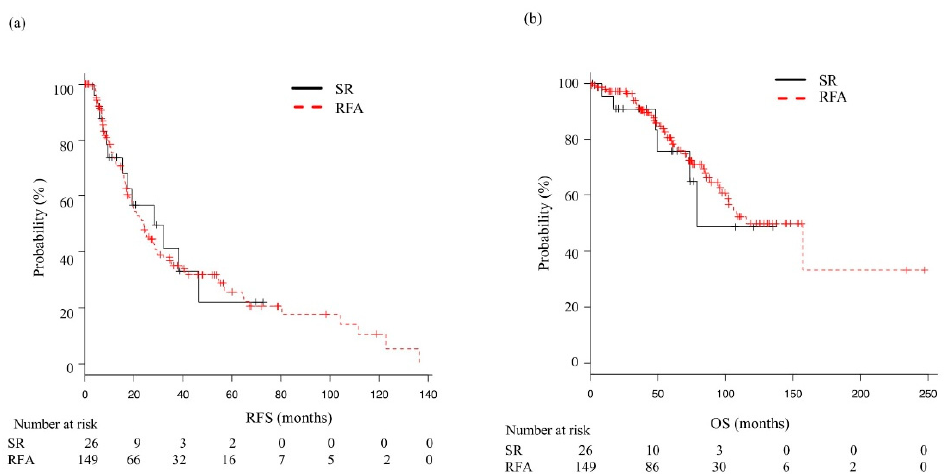
Figure 4. Recurrence-free survival (RFS) and overall survival (OS) following surgical resection (SR) or radiofrequency ablation (RFA) in albumin–bilirubin (ALBI) grade 1 patients. ( a ) Median RFS in the SR and RFA groups was 28.2 (95% CI: 15.4–46.3) and 24.0 (95% CI: 18.9–28.5) months, respectively ( p = 0.881). ( b ) Median OS in the SR and RFA groups was 78.9 (95% CI: 49.3—not applicable) and 115.3 (95% CI: 96.0—not applicable) months, respectively ( p = 0.651).